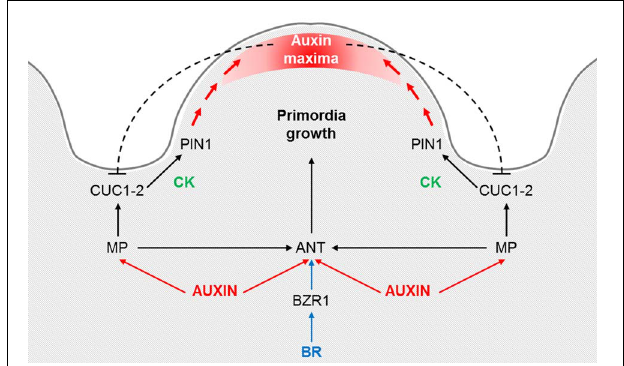
FIGURE 2 | Proposed model for the control of the ovule primordia initiation. Auxin triggers ANT and MP expression, which in its turn is required for ANT , CUC1 and CUC2 expression during the early stages of placenta development and ovule primordia formation. ANT expression is also regulated by brassinosteroids (BR), specifically being directly regulated by BZR1. ANT controls cell proliferation in the placenta and ovules, whereas CUC1 and CUC2 establish the boundaries and control PIN1 expression, which is required for primordia formation. Cytokinin (CK) may act downstream of CUC proteins in promoting PIN1 expression. Once the primordia have formed, auxin accumulates at the edge of the developing ovule. An inhibitory loop of auxins on CUC1 and CUC2, as it is postulated for the leaf serration, could be happening at the ovule boundaries. Adapted from Galbiati et al.